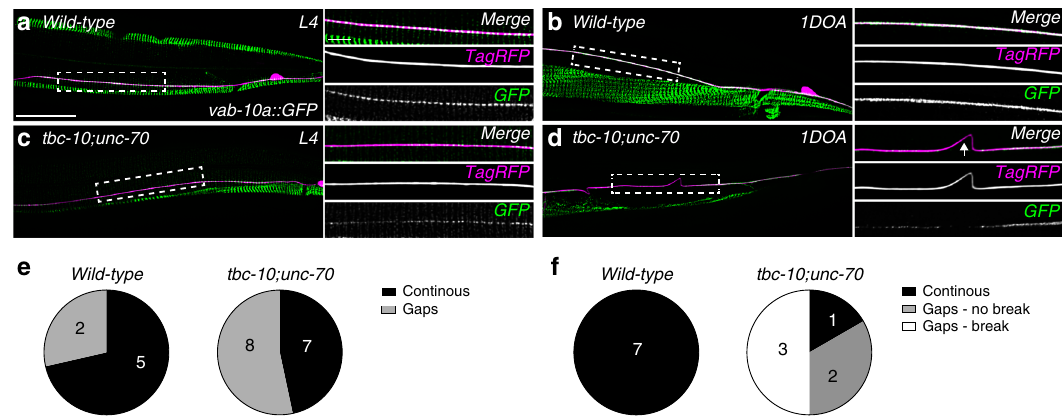
Fig. 4 VAB-10a/spectraplakin localization is disrupted in tbc-10;unc-70 mutants. a , b Deconvolved spinning disk confocal maximum projection of typical endogenous VAB-10a::GFP localization at the L4 ( a ) and 1-day-old adult (1DOA) ( b ) stage in wild-type animals from a lateral perspective, with the PLM neuron labeled with a cytosolic TagRFP ( Pmec-17::tagRFP , magenta). The side panels in a – d show the boxed area indicated in the left panel as a merged image and individual channels. c , d Deconvolved spinning disk confocal maximum projection of typical endogenous VAB-10a::GFP localization at the L4 ( c ) and 1DOA ( d ) stage in tbc-10(vd31);unc-70(n493) animals from a lateral perspective, with the PLM neuron labeled with a cytosolic TagRFP ( Pmec-17:: tagRFP , magenta). Arrow in d indicates a buckle in the PLM axon. Scale bars in a are 25 μ m and 5 μ m in the left and side panels, respectively. e Normalized intensities of VAB-10a::GFP along a 50 μ m of the PLM axon at the L4 stage were scored as containing gaps (de fi ned as >5 puncta with intensity values< 0.2 a.u.) or continuous attachment (de fi ned as < 5 puncta with intensity values< 0.2 a.u.). f VAB-10a::GFP localization at the 1DOA stage was scored as continuous (no gaps in localization greater than 10 μ m) or containing gaps (a region of no localization greater than 10 μ m) with and without axonal breakage. N -values are indicated on charts and represent the number of individual animals scored for each condition.